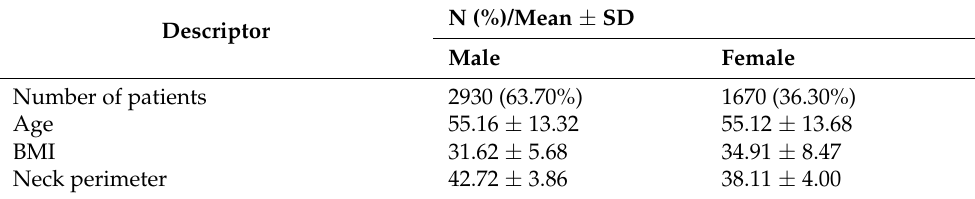
Table 1. Summary of the main descriptors for the training data